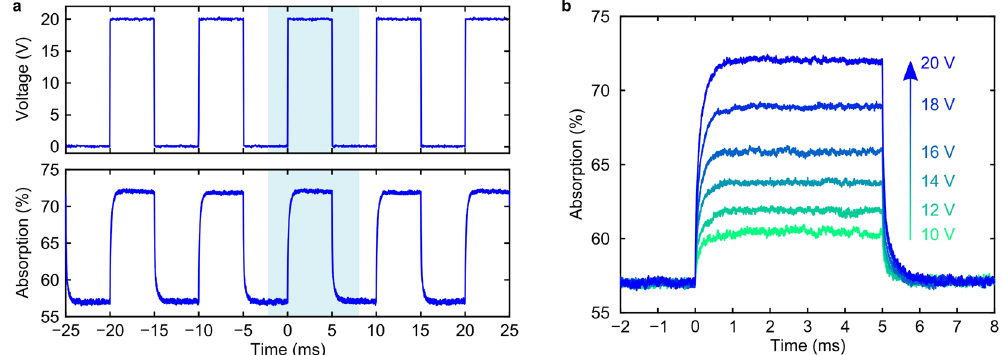
Figure 5. Modulating metasurface absorption. ( a ) Square modulation of the applied voltage U between 0 V and a peak voltage of 20 V (top) at 100 Hz and the resulting absorption modulation at a wavelength of 1310 nm (bottom). ( b ) One cycle of modulation for peak voltages from 10 V to 20 V in steps of 2